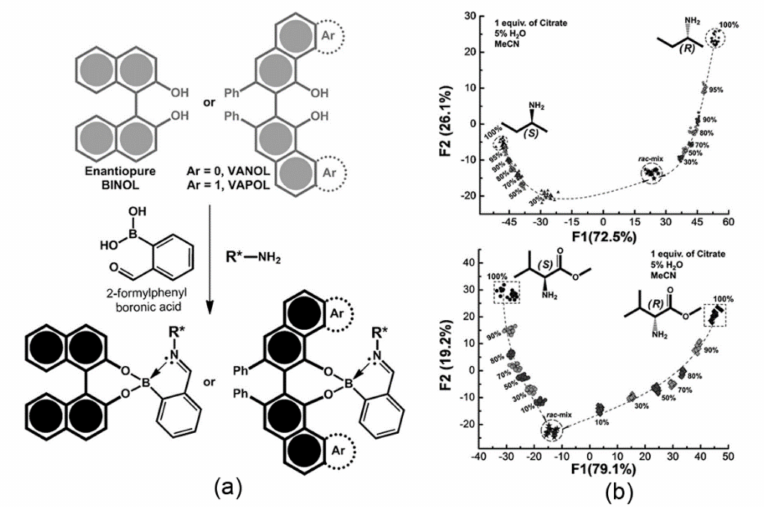
Figure 12. ( a ) Formation between a diol-type fluorophore, 2-FPBA, and a chiral amine or amine deriva- tive. ( b ) LDA describing a semi-quantitative assay of enantiomeric composition of 2-aminobutane (top) and valine methyl ester (bottom) by using the array reported by Anzenbacher’s group. Adapted from Ref. [48] with permission from Wiley, Copyright